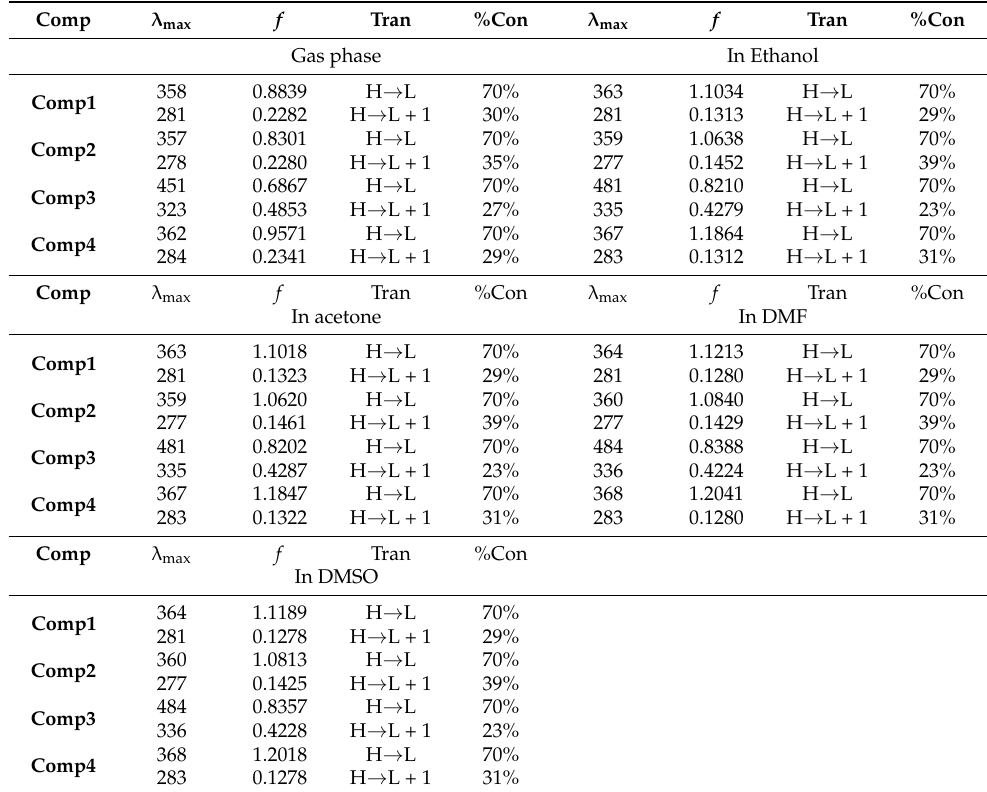
Table 3. The absorption wavelengths ( λ max , nm), oscillator strengths ( f ), percent contribution, and key transitions in the gas phase as well as in solvents (ethanol, acetone, DMF, and DMSO) of benzothiazole derivatives at the TD-B3LYP/6-31+G**